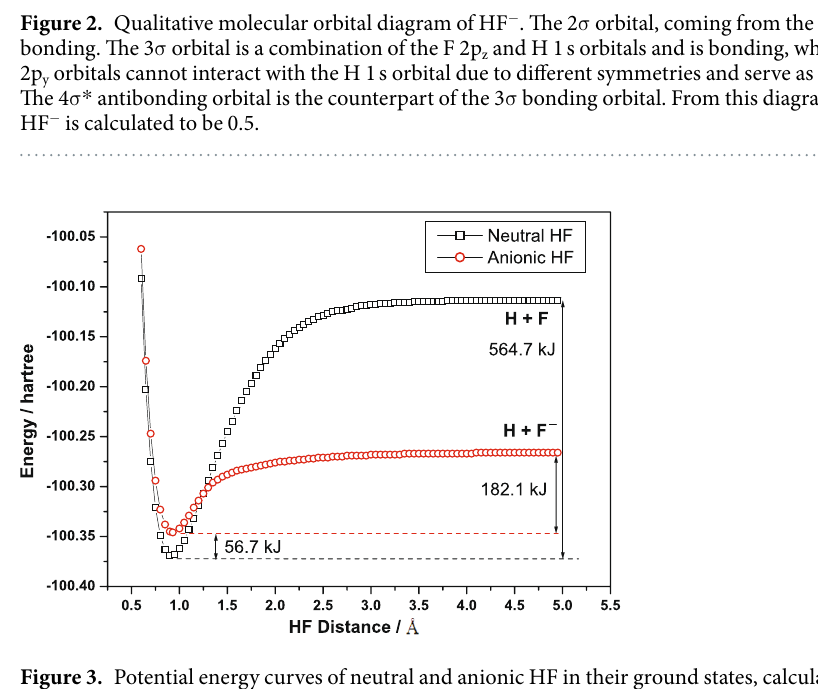
Figure 3. Potential energy curves of neutral and anionic HF in their ground states, calculated at a CCSD(T)/ Aug-cc-pVQZ level of theory. The energy difference between the two species is listed with zero-point energy correction. In comparison, the experimental bond dissociation energy (D 0 ) of HF is reported to be 565.3 kJ mol − 1 40